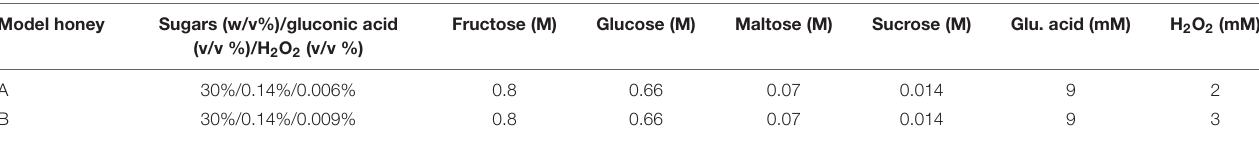
TABLE 1 | Composition of the model honeys. Model